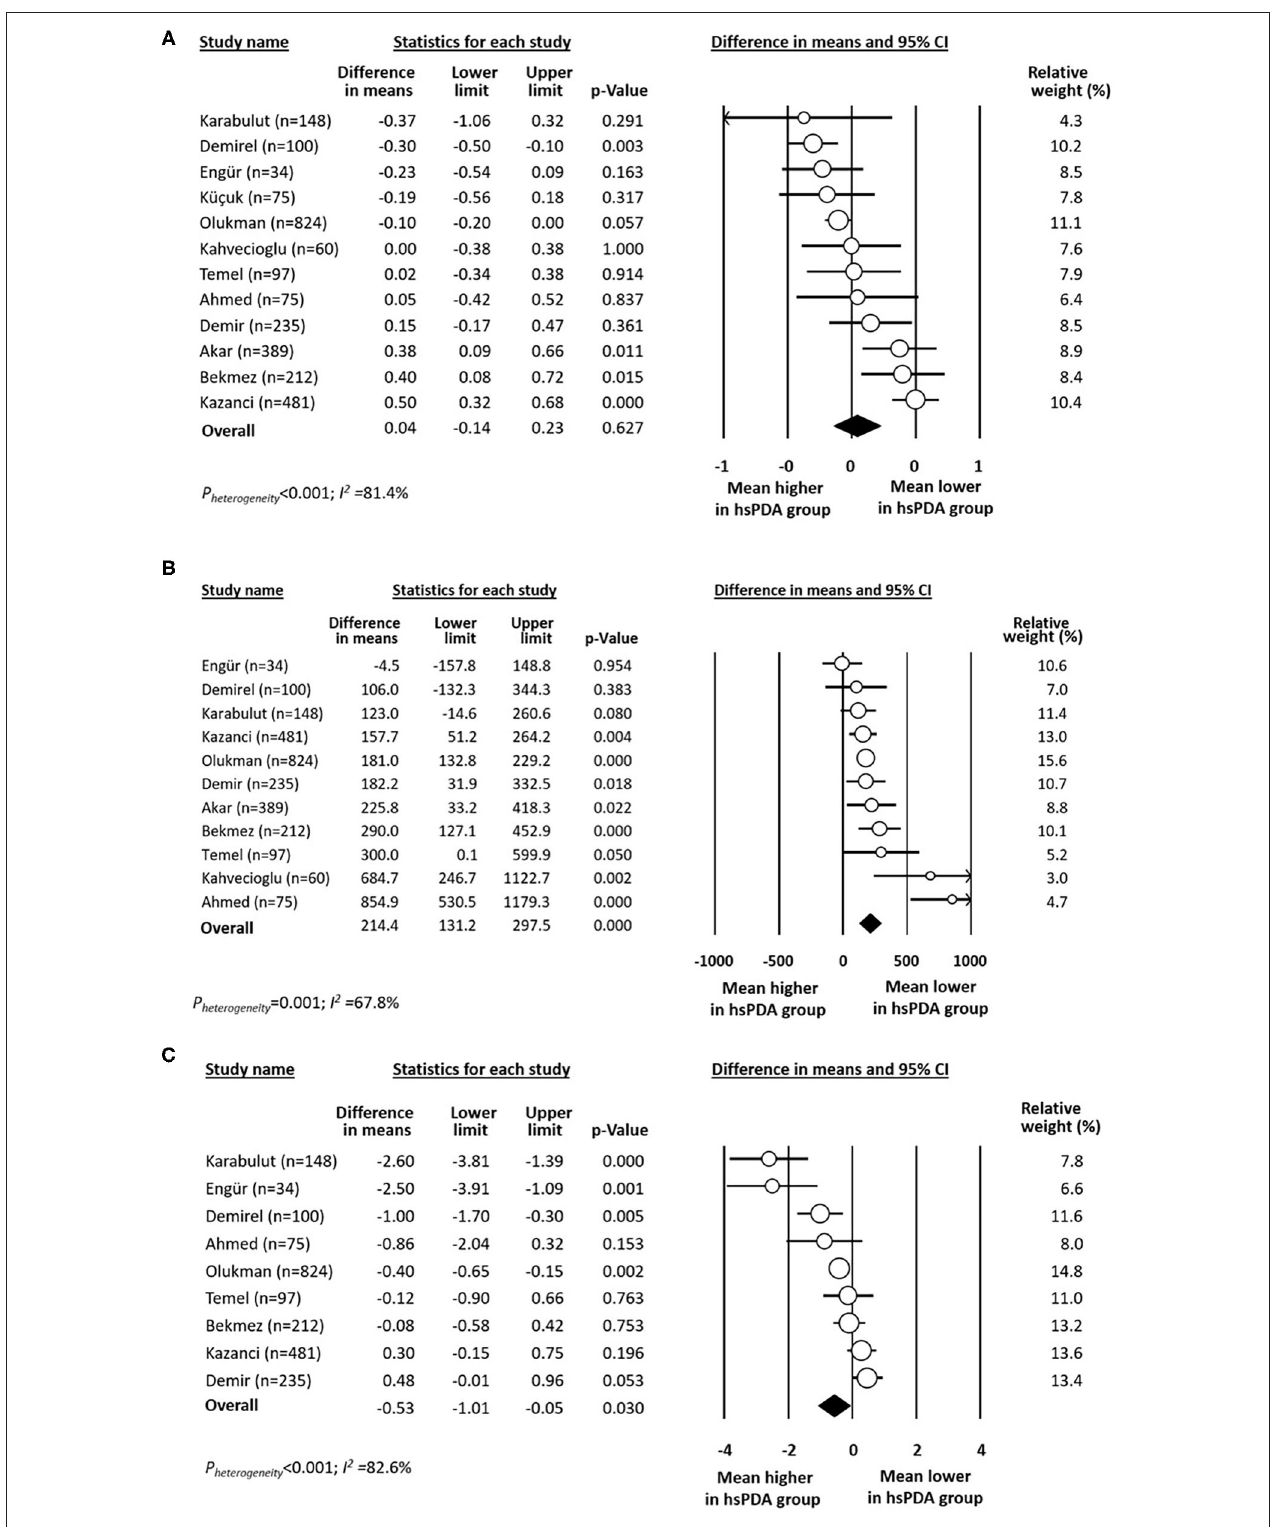
FIGURE 4 | Forest plot for studies examining the difference (PDA-no minus PDA-yes) in (A) mean platelet volume (MPV), (B) platelet mass, and (C) platelet distribution width (PDW) in the first day(s) of life in infants with and without hemodynamically significant PDA (hsPDA).